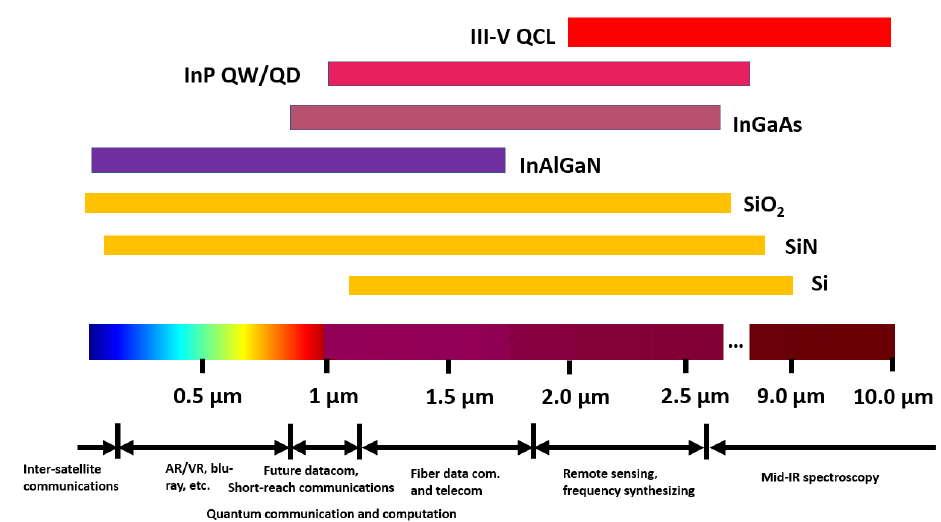
Figure 9. Spectral transparency of SiO 2 , Si and SiN (yellow); bandgap of III-V materials and gain structures (purple to red) and representative